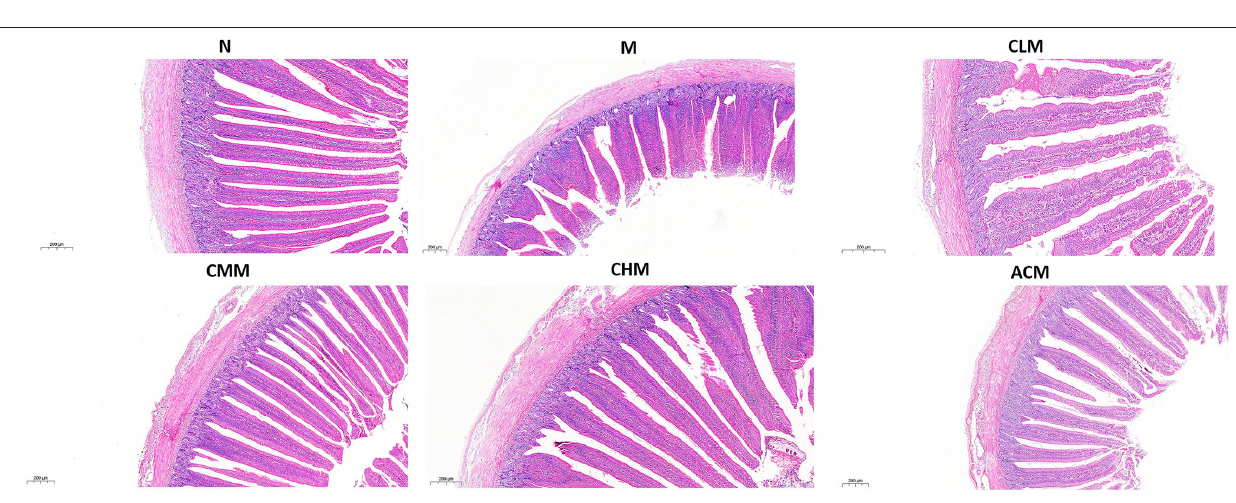
FIGURE 7 | Effects of CSP on intestinal murphology of chicken jejunum H&E (100x, Scale bar =